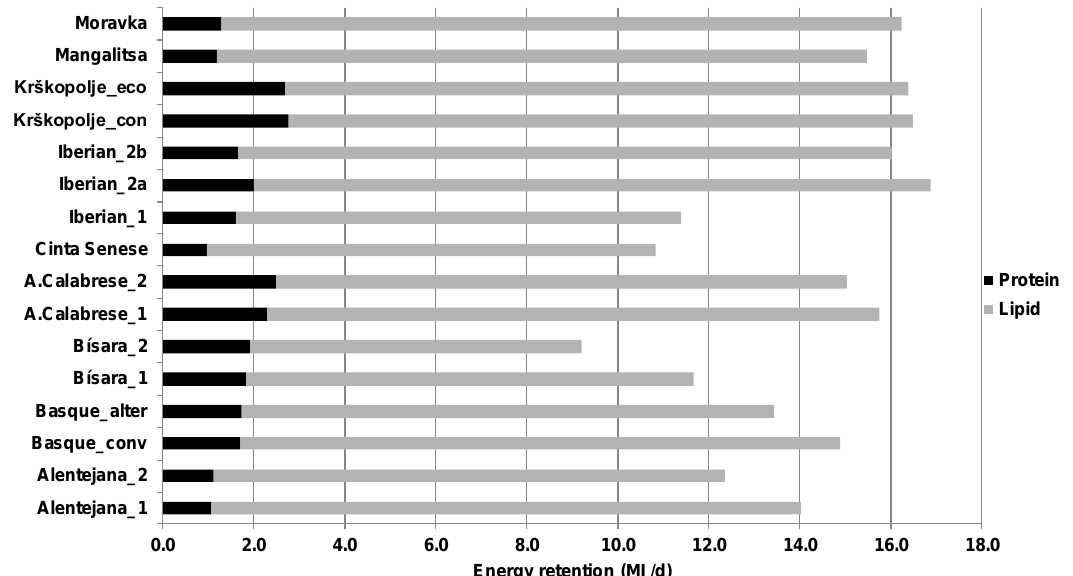
Figure 4. Retained energy in protein or lipid (MJ / d) for nine local breeds during the period 40–100 kg BW.